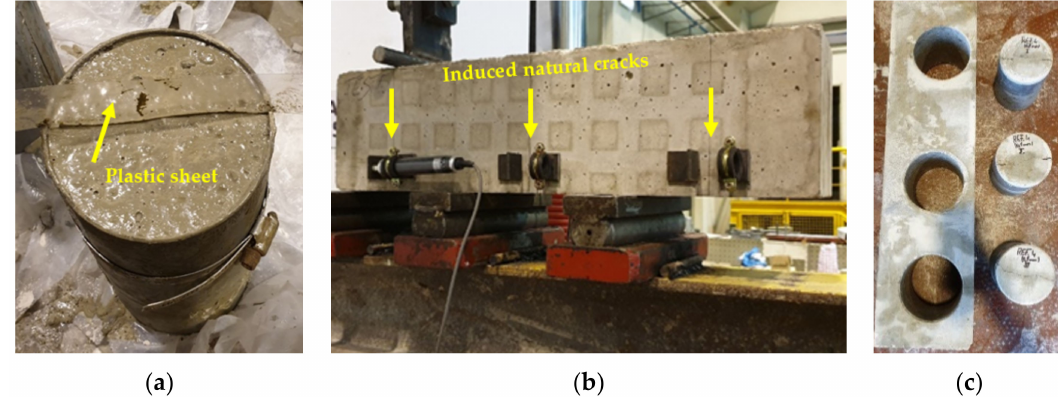
Figure 1. Introducing ( a ) artificial cracks using a plastic sheet and ( b ) natural cracks from bending tests. ( c ) Drilled core specimens after natural